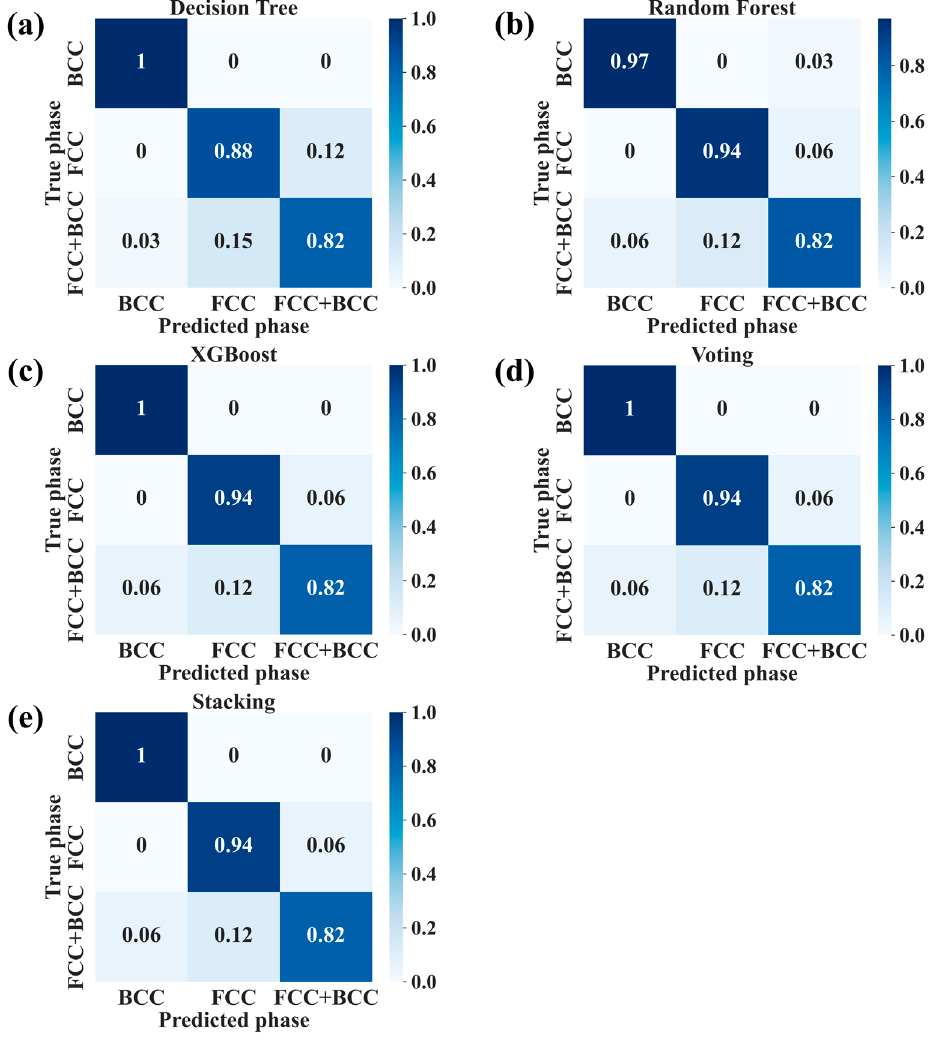
Figure 7. Confusion matrix for training and testing of current data set using ( a ) Decision Tree, ( b ) Random Forest, ( c ) XGBoost, ( d ) Voting, and ( e ) Stacking. (Y axis is true phases and X axis is pre- dicted phases for all matrices).